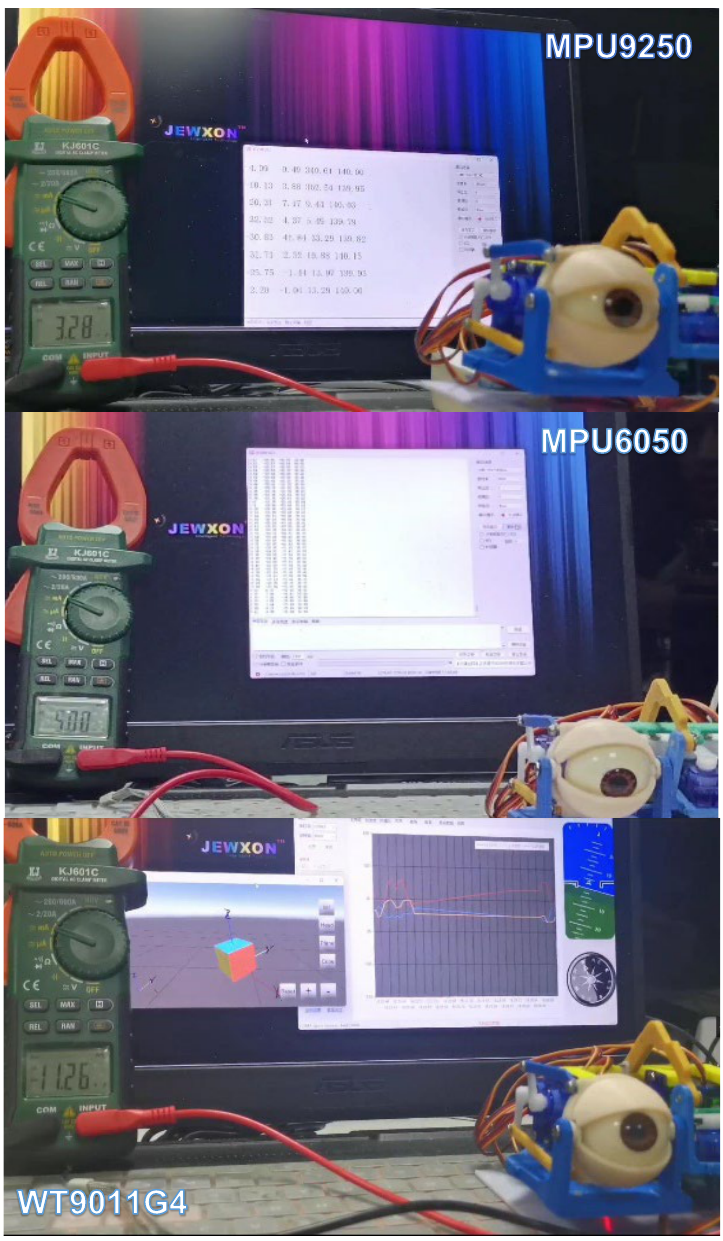
Figure 14. Actual power consumption of three different IMUs in the working state is displayed.